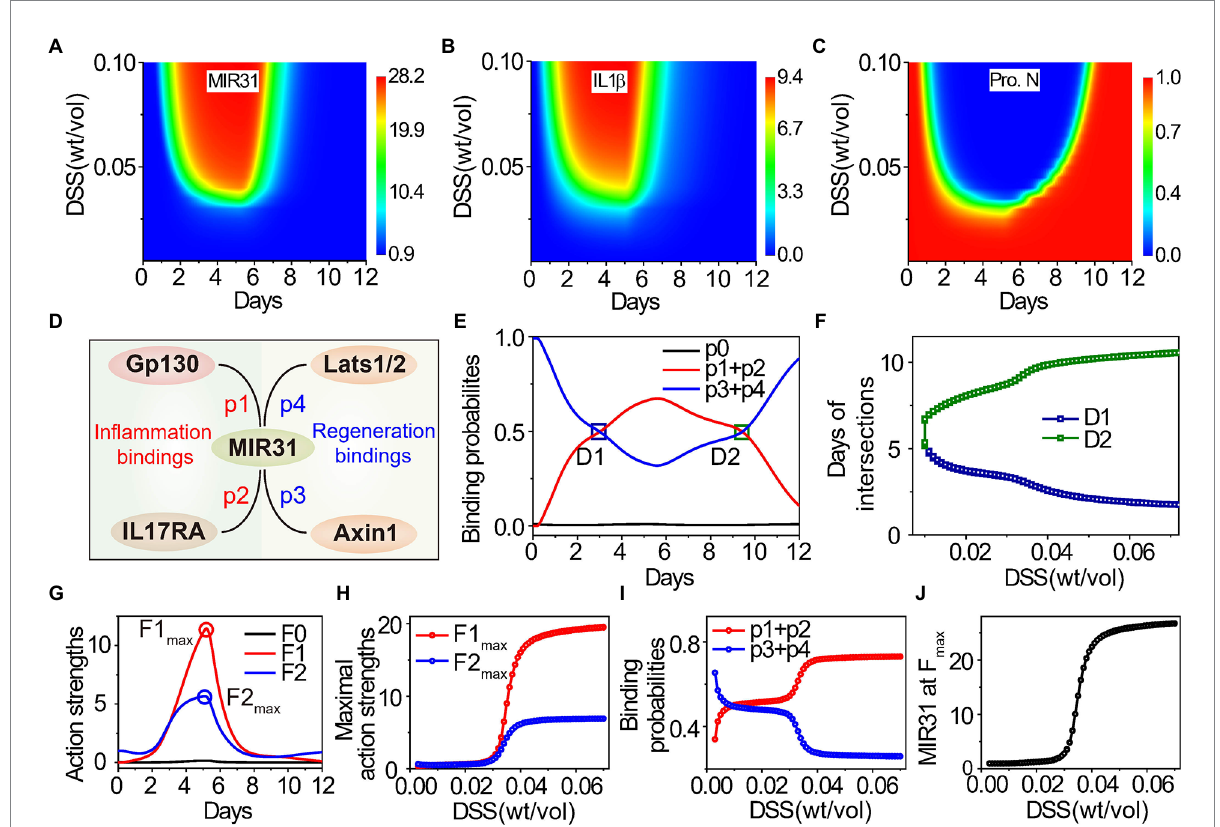
FIGURE 6 Effects of DSS concentration on inflammatory response and epithelial regeneration. (A – C) Dynamic results of MIR31 expression (A) , IL1 β expression (B) , and the proliferative cell number (C) under continuous changes in DSS concentration. (D) The probabilities of MIR31 binding to Gp130 ( p1 ), IL17RA ( p2 ), Axin1 ( p3 ), and Lats1/2 ( p4 ). (E) Dynamics of the probability assignment of MIR31, where p1 + p2 and p3 + p4 correspond to MIR31-inhibited inflammation probability and MIR31-promoted regeneration probability, respectively, and p0 represents the probability that MIR31 is in a resting state. (F) The influence of DSS concentration on two intersections D1 and D2 of the two probability curves in (E) . (G) Dynamics of the action strengths of MIR31-inhibited inflammation and MIR31-promoted regeneration. The influence of DSS concentration on the maximal action strengths (H) and on the probabilities of MIR31-inhibited inflammation and MIR31-promoted regeneration (I) and the MIR31 expression (J) corresponding to the two maximal action strengths in (G) . The results of (C) are compared with the maximum proliferative cell number. In (E,G) , MIR31 is divided into three categories: MIR31 in the resting state (black), MIR31 inhibiting inflammation (red) and MIR31 promoting regeneration